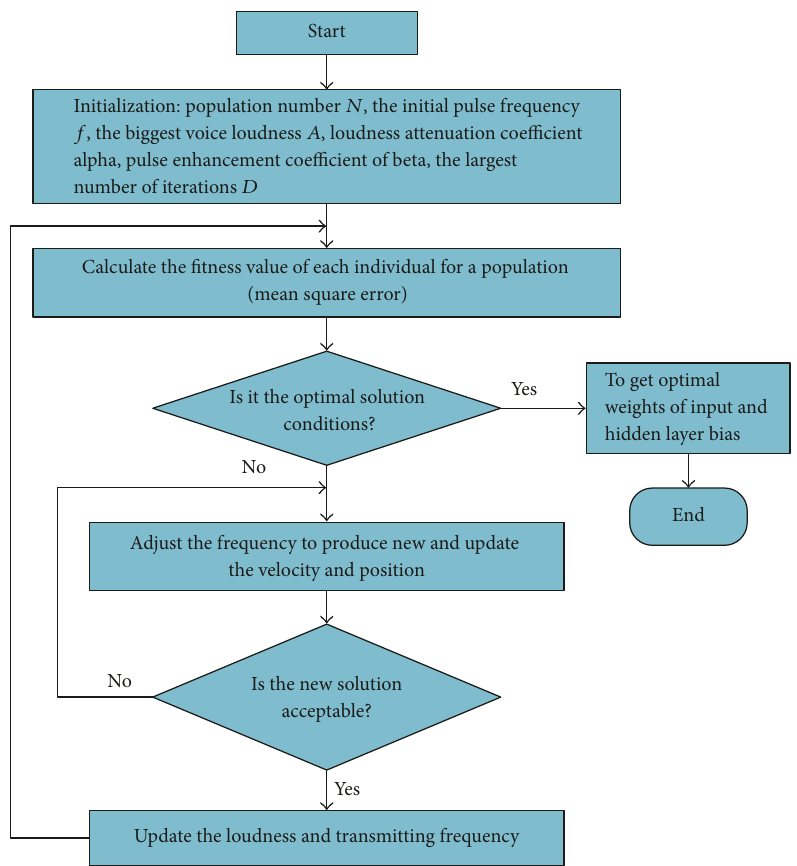
Figure 5: The flow chart of BA optimized ELM algorithm.